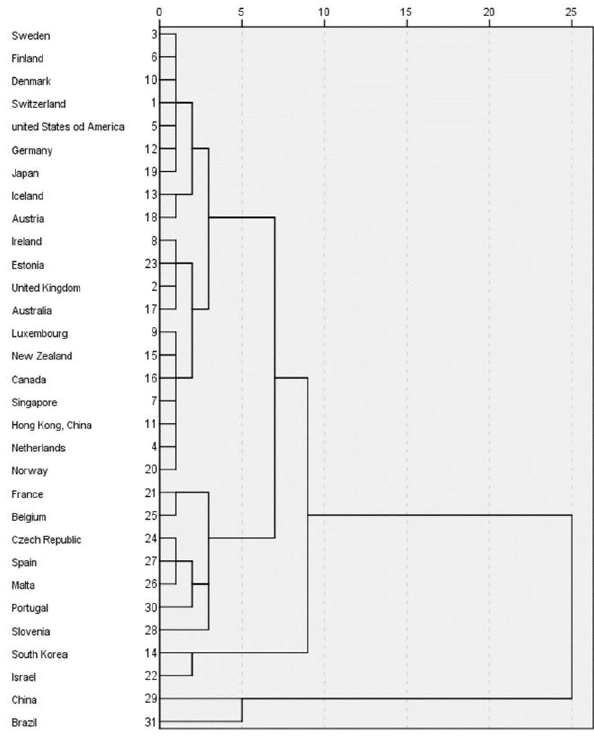
Figure 9. Formation of Clusters of the Most Innovative countries (in 2015) and Brazil‟s Position In 2015, Brazil continued to cluster with China, just as South Korea and Israel remained clustered. Northern European countries (Denmark, Finland, Iceland and Sweden) also remained in the same